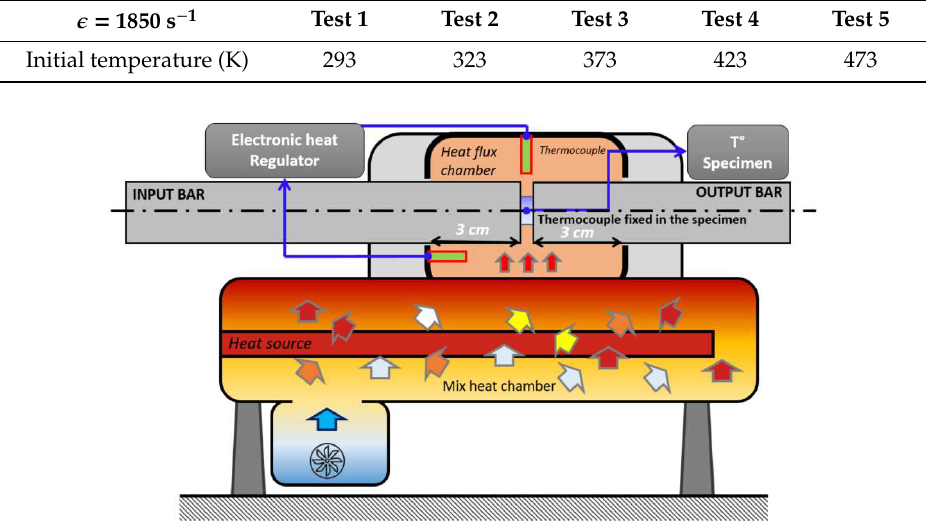
Figure 11. Schema of the oven used for the test using SHPB at high temperatures [11].